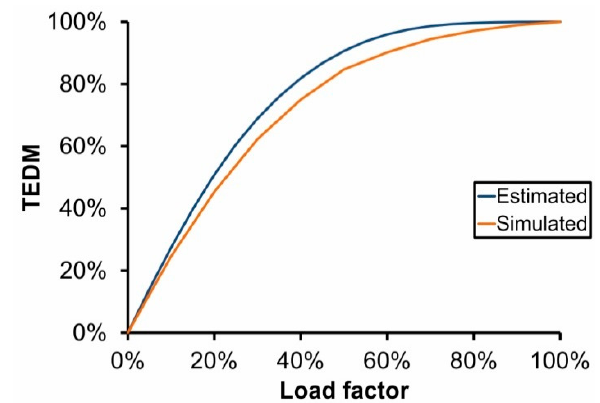
Figure 9. Estimated vs. simulated load curves for the high-insulated House in climate Zone E.